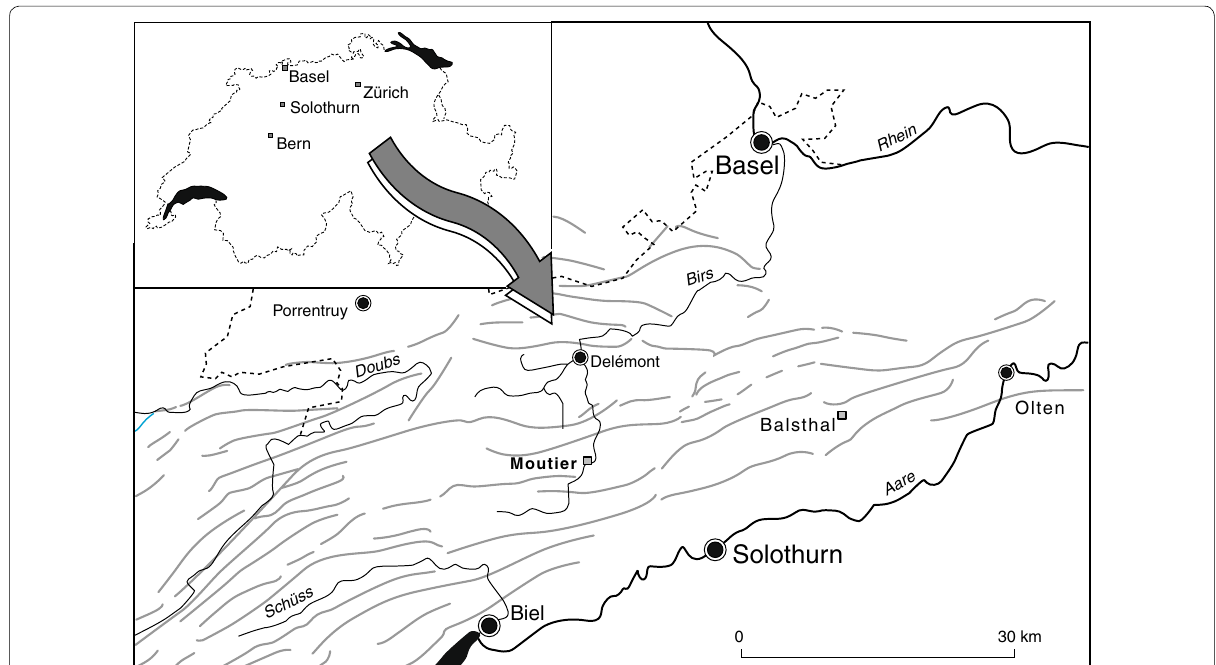
Fig. 1 Geographic position of the original quarry of A.